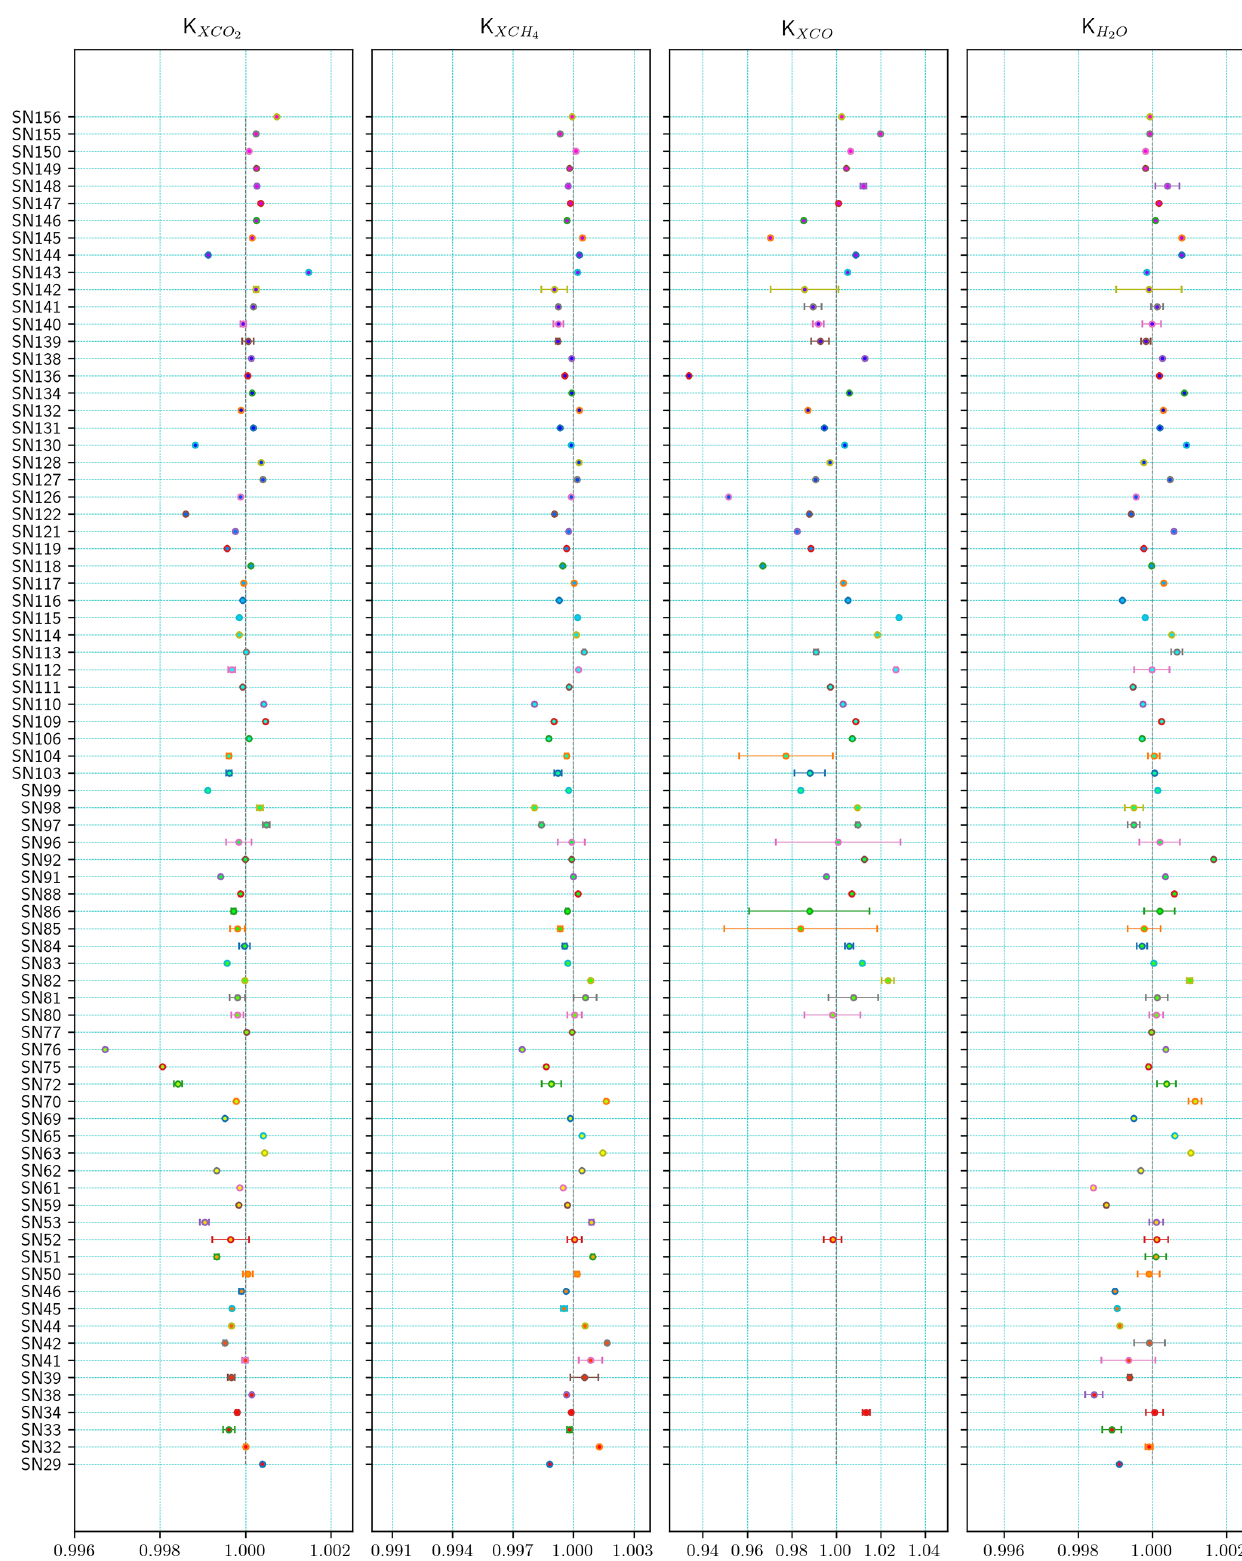
Figure 24. Correction factors for XCO 2 , XCH 4 , XCO and XH 2 O from left to right, respectively, calculated for all EM27/SUN spectrometers. The error bar represents the standard deviation, and it is shown only for the instruments with more than one side-by-side measurement in Karlsruhe. The dashed line represents the ideal value “1.0” (practically realized by the COCCON reference spectrometer